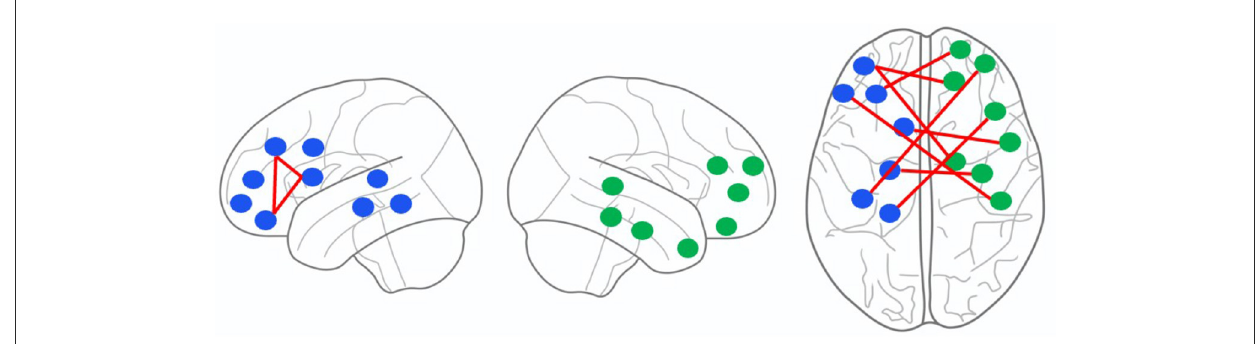
FIGURE5 The location of channels with strong correlation on the cerebral cortex. From left to right , it is shown as the left hemisphere, the right hemisphere and the whole cerebral cortex. The blue and green dots represent channels, and the red lines represent the edges between